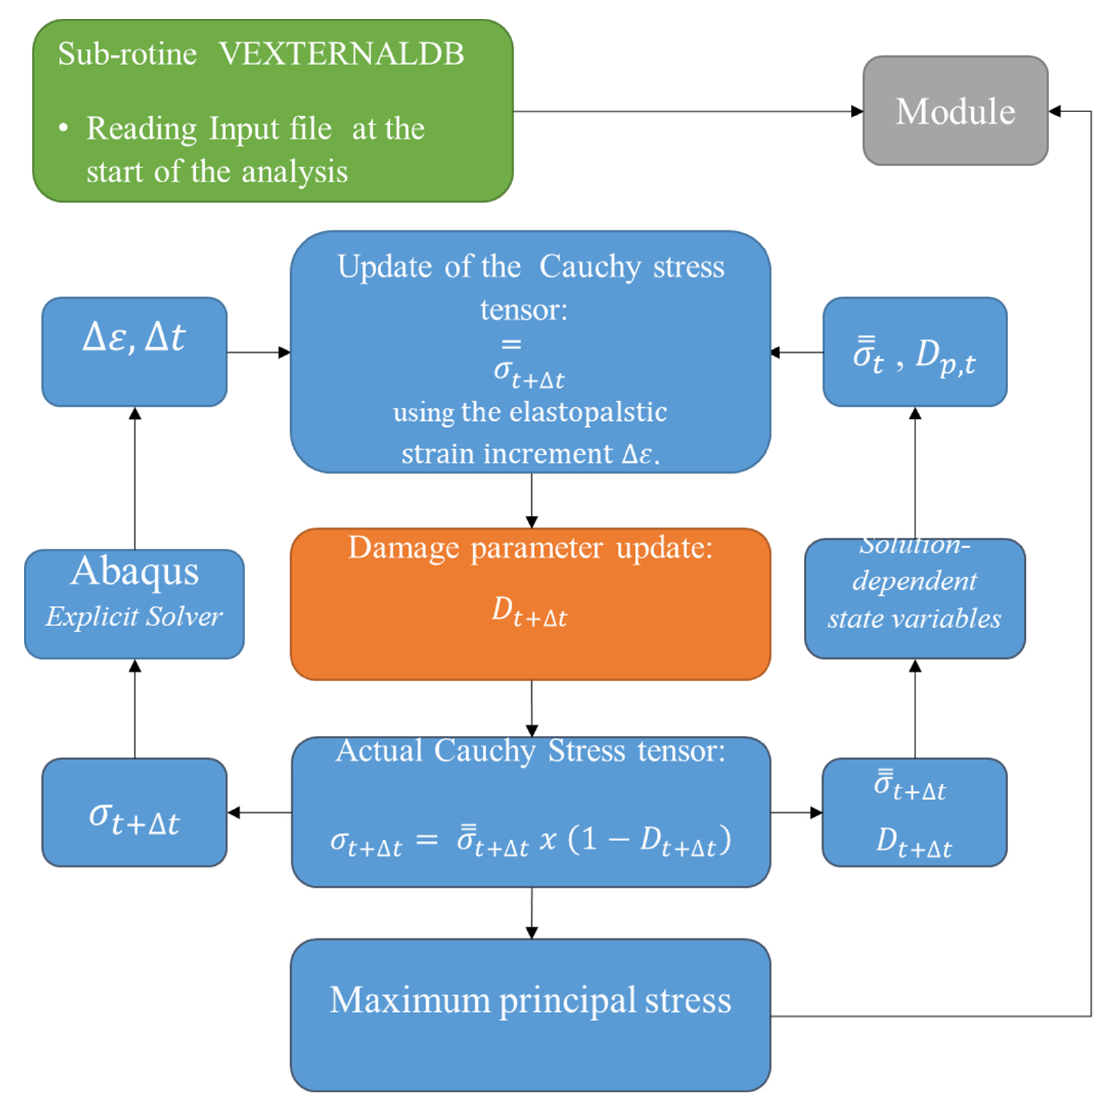
Figure 3. VUMAT operation flowchart .